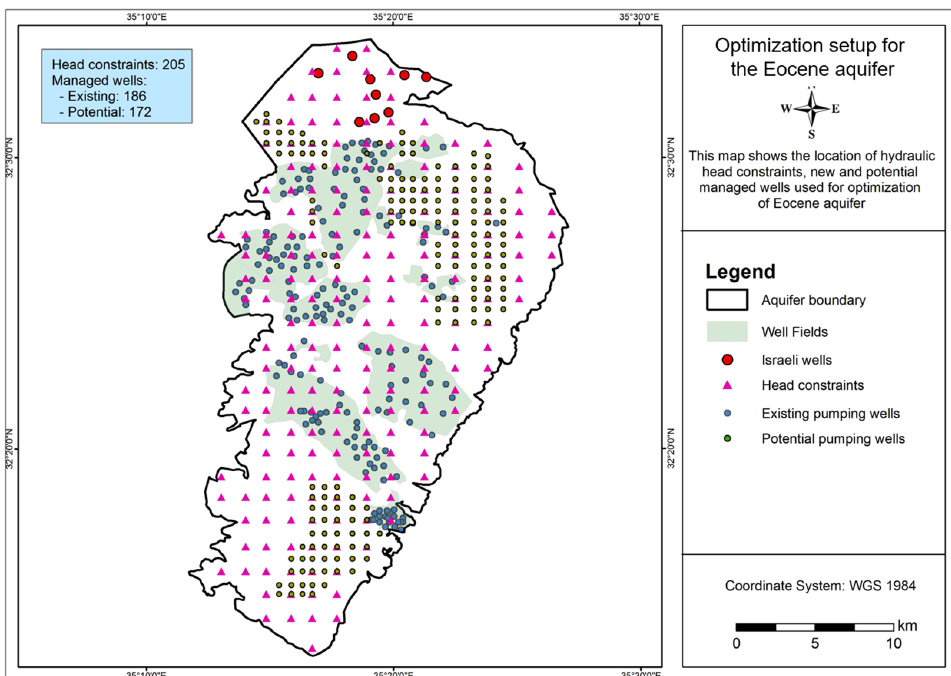
Figure 12. Schematic representation of abstraction strategies.